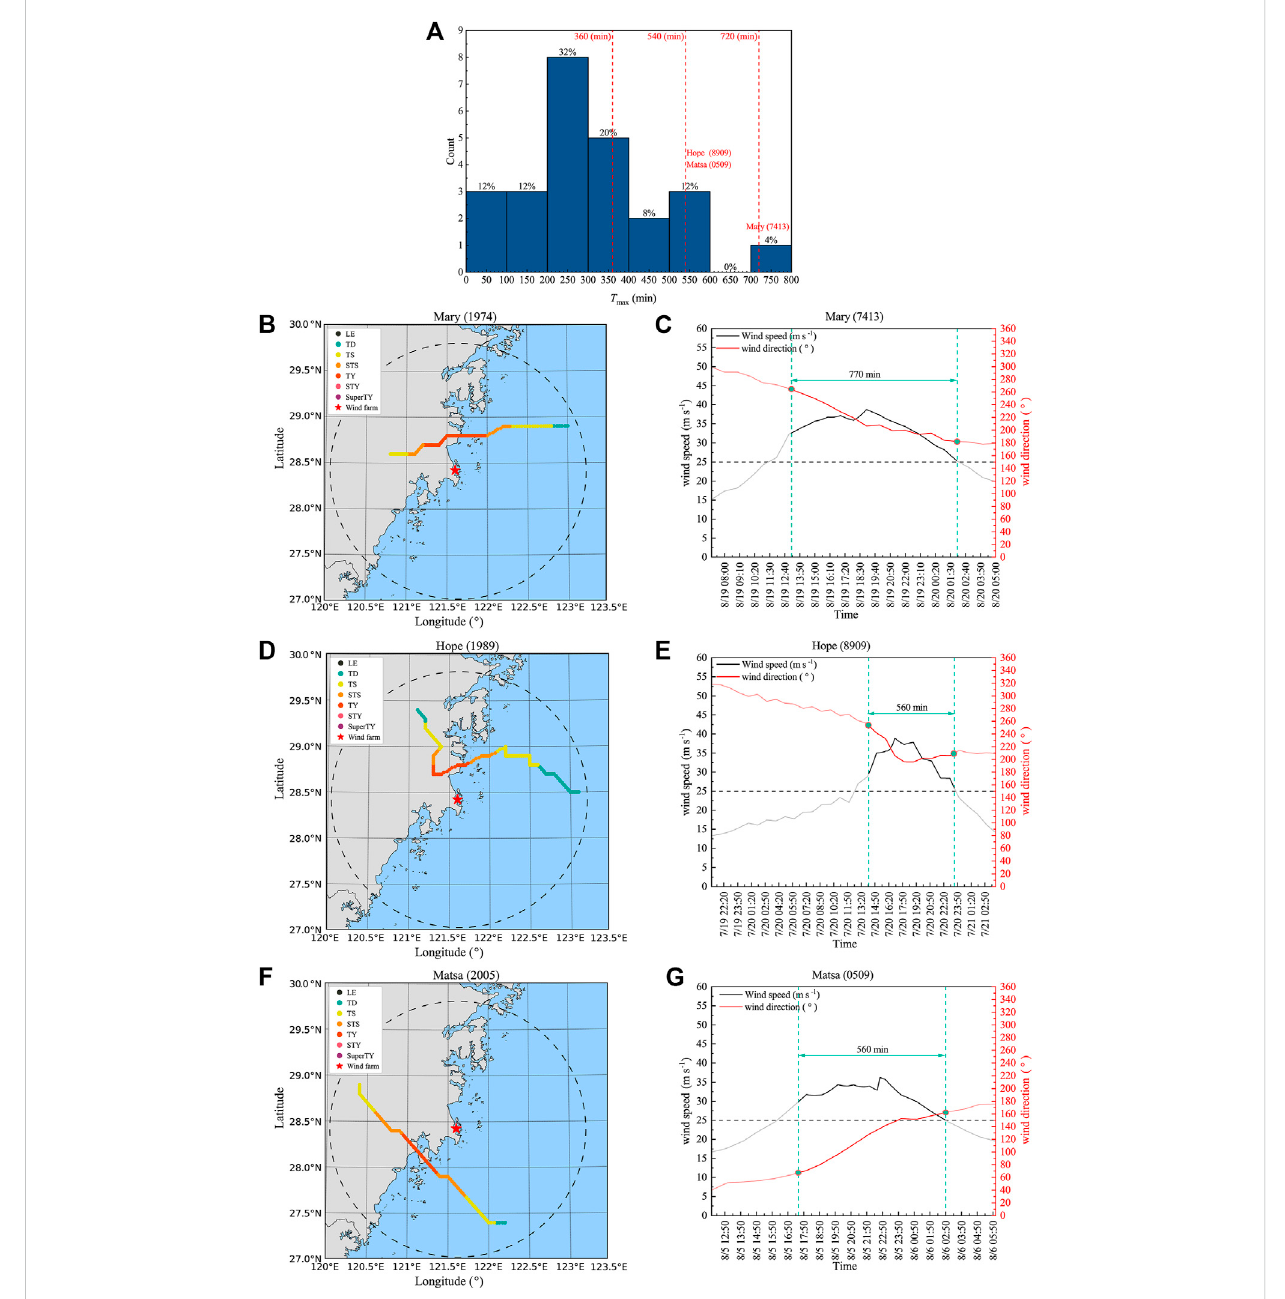
FIGURE 8 (A) Frequencydistributionofthemaximumdurationofwinddirectionchangesathubheightunderthein fl uenceoftropicalcyclones( T and F) the best-track positions and intensities and (C,E and G) temporal variations of wind speed and wind direction for tropical cyclones (B and C) Mary (1974), (D and E) Hope (1974), and (G and H) Matsa (2005). Orange dashed lines in (A) are the threshold cutoffs of 360, 540, and 720 min, black dashed circle represents the study area with radius of 150 km centered on the wind farm, and green dashed lines in (C,E and G) denote the starting and ending time points of T max